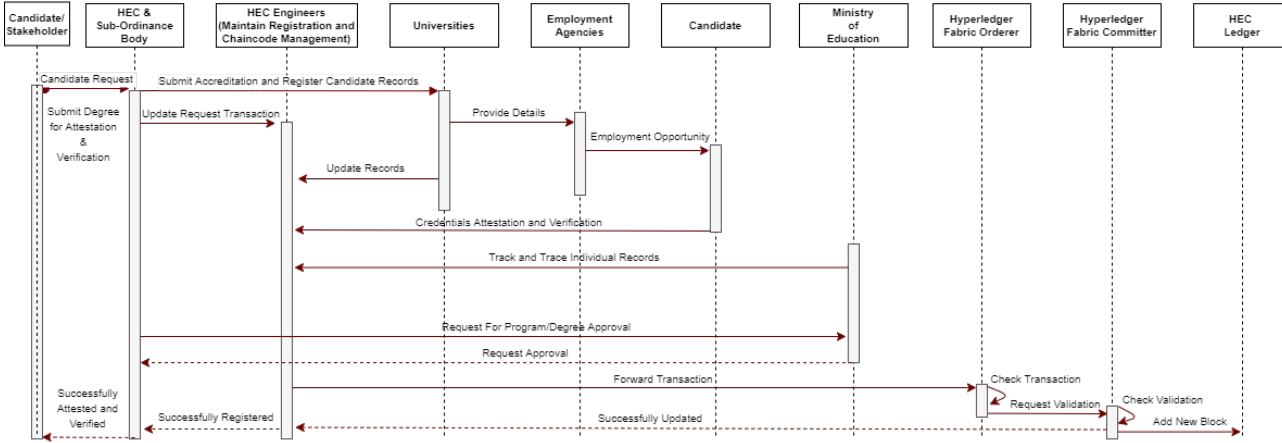
Figure 7. Sequence diagram of degree attestation and credential verification transaction processes.